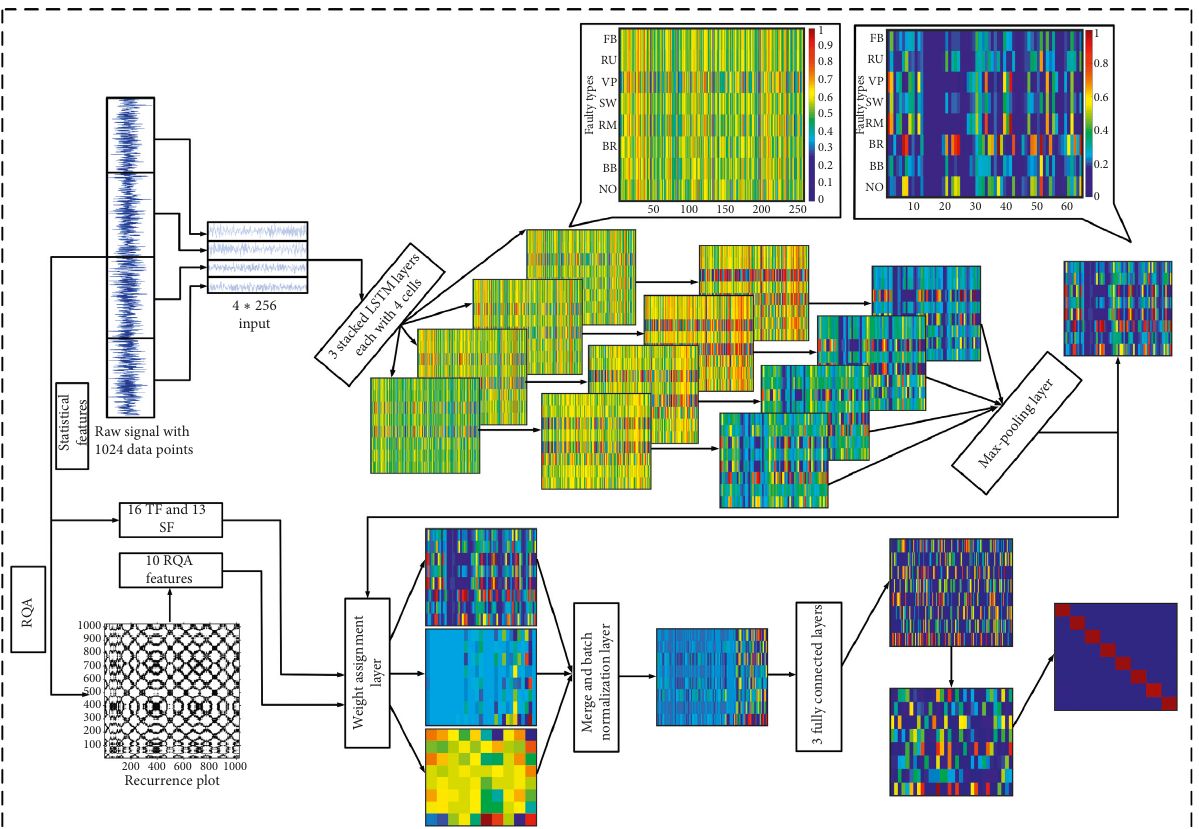
Figure 9: Visualization of the outputs of every step of 8 different